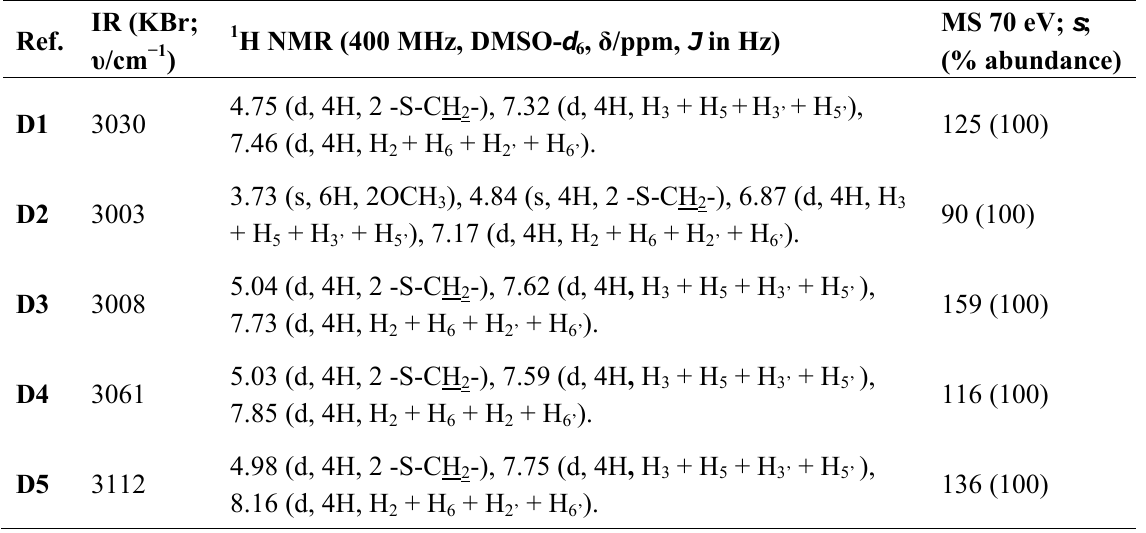
Table 5. Spectroscopic data (IR, 1 H-NMR and MS) for the new compounds.